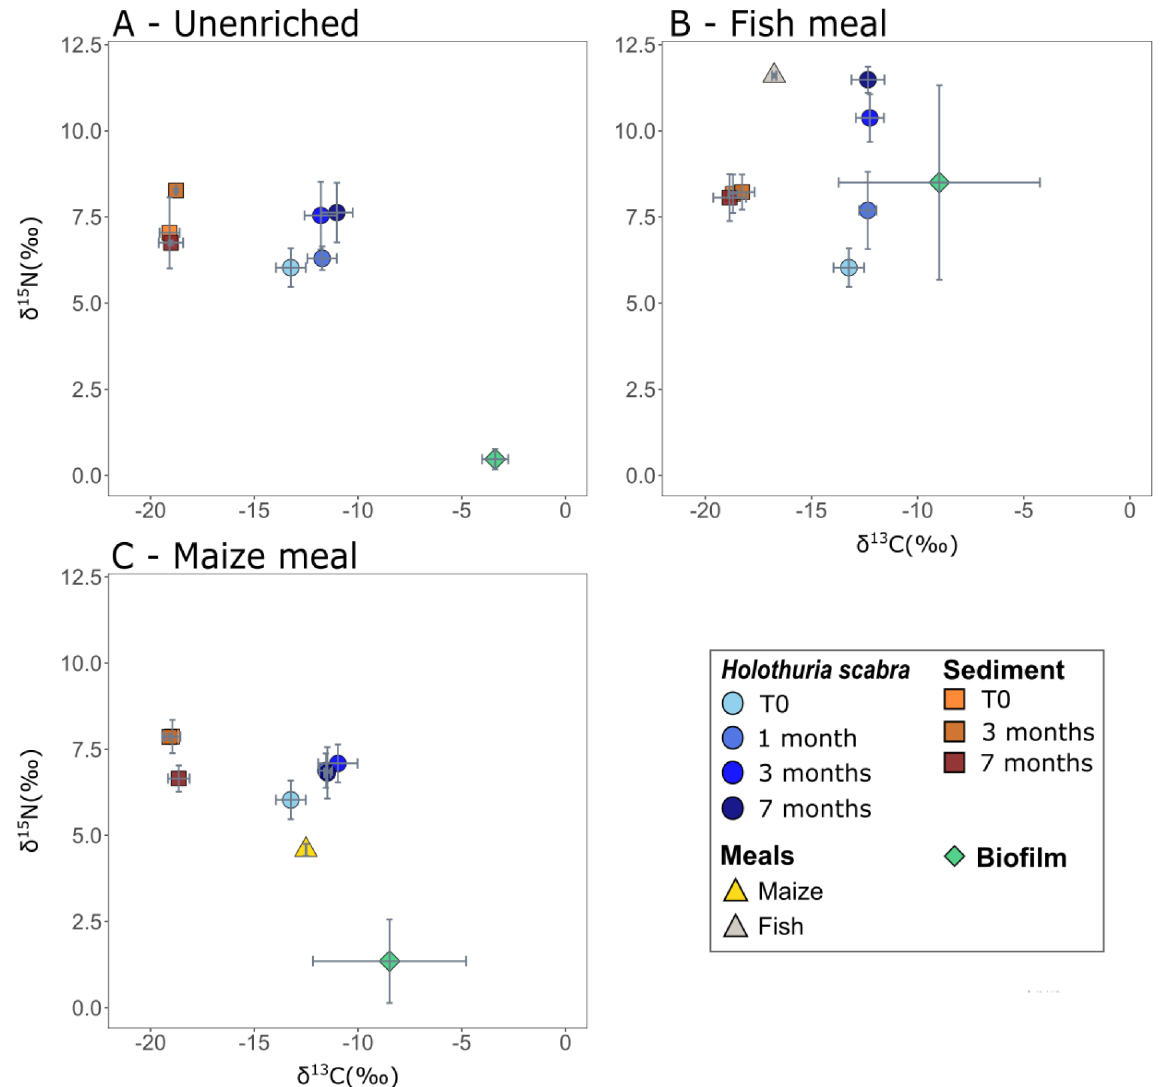
Fig. 1. d 13 C vs. d 15 N (mean ±S.D.) of Holothuria scabra and its potential food sources (sediment. bio fi lm. maize ad fi sh meals) during the feeding experiment. H. scabra reared on shrimp-farm sediment only (unenriched treatment) (A). H. scabra reared on shrimp-farm sediment and fi shmeal (B) and H. scabra reared on shrimp-farm sediment and maizemeal (C). Fish and maize meal stable isotope compositions did not vary through the